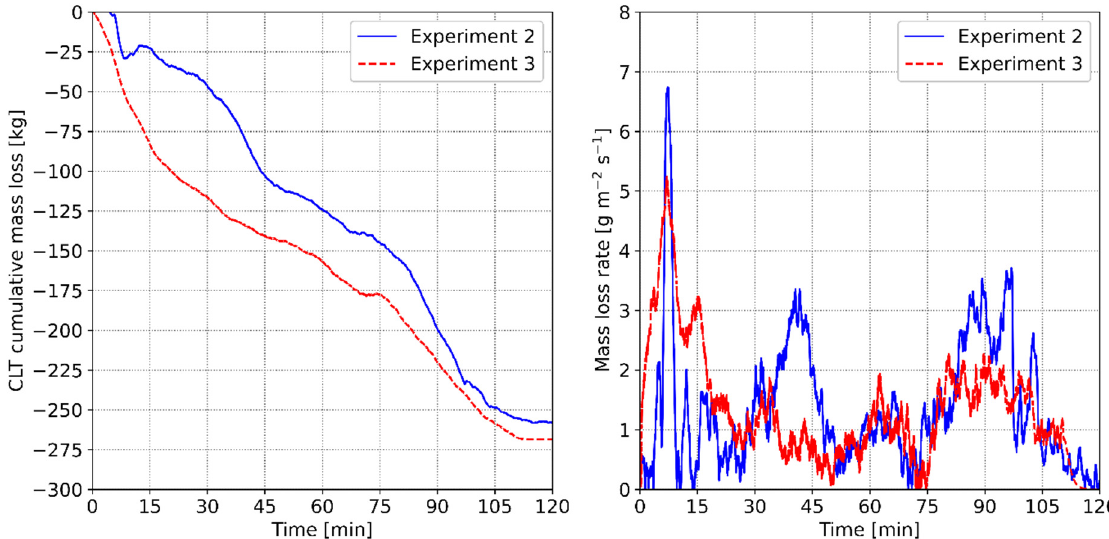
Figure 8. CLT mass loss ( left ) and mass loss rate ( right ) for Experiments 2 and 3.